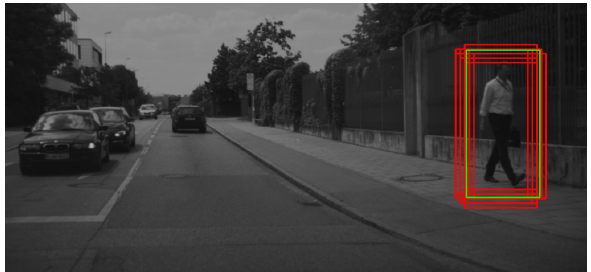
Figure 7: Vehicle camera image. Pedestrian detector already ap- plied on the image. Bounding rectangles (multiple detections on different scales) of detected pedestrian in red, ground truth data in